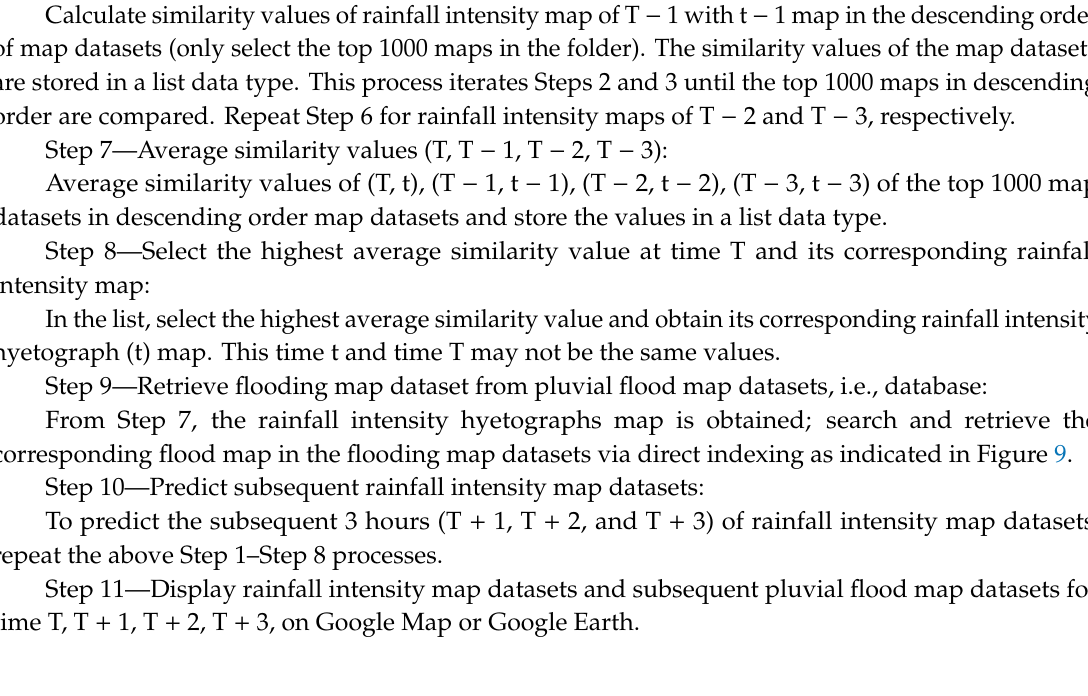
Figure 8. A scenario of rainfall intensity hyetograph converting into a color-classified image dataset and retrieving its corresponding flood map dataset in